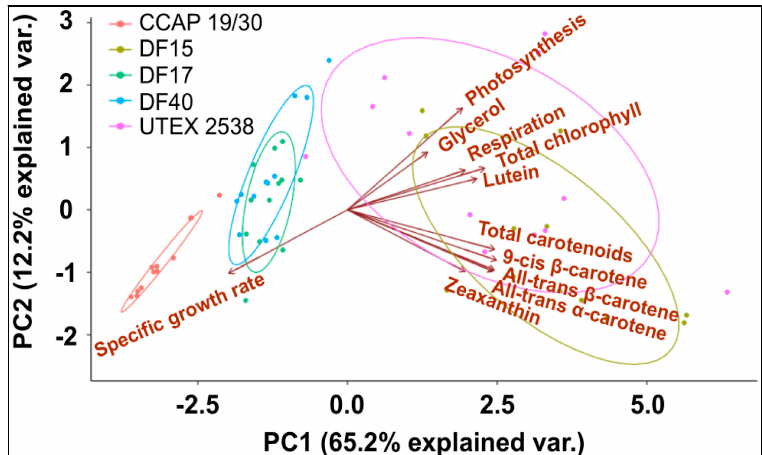
Figure 8. Principle component analysis of 11 traits ( all-trans β -carotene, 9-cis β -carotene, glycerol, lutein, zeaxanthin, all-trans α -carotene, photosynthesis, respiration, total carotenoids, total chlorophyll, and specific growth rate) for all five Dunaliella strains cultivated at four light intensities.